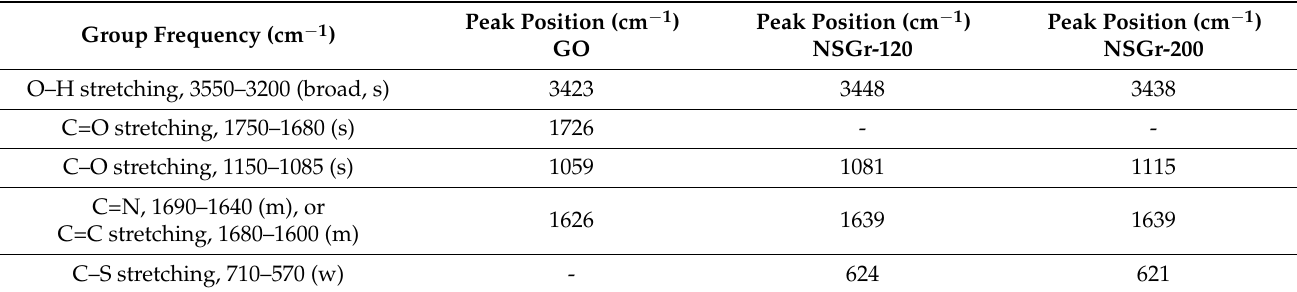
Table 3. The infrared bands of GO, NSGr-120, and NSGr-200 samples. Group Frequency (cm − 1